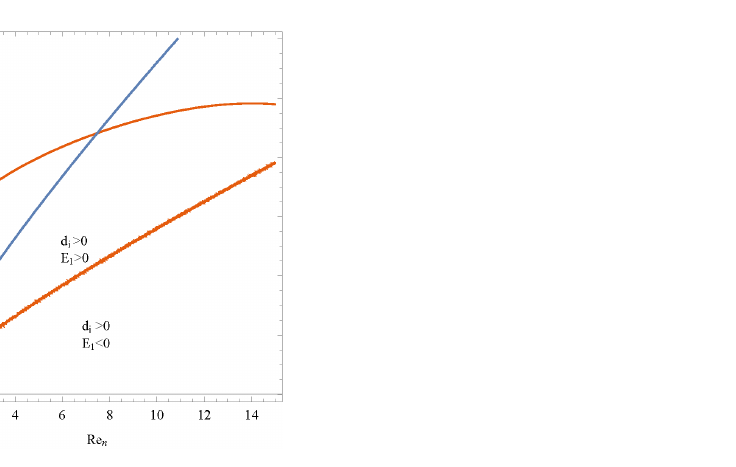
Figure 7. Nonlinear neutral stability curves of the film flow for various α and Re at n = 0.95, Z = − 0.32.